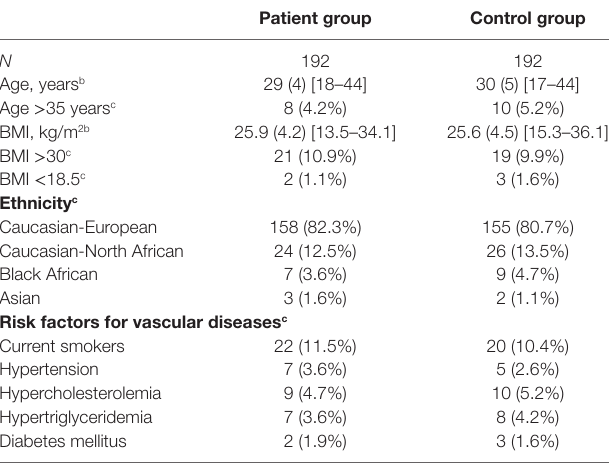
TaBle 2 | Baseline characteristics of the sequenced patients and controls. a